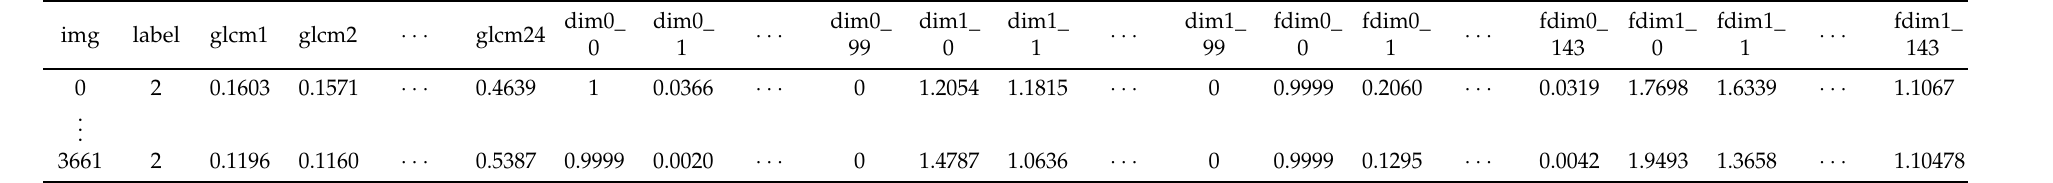
Table 2. Results of feature engineering process applied to the APTOS